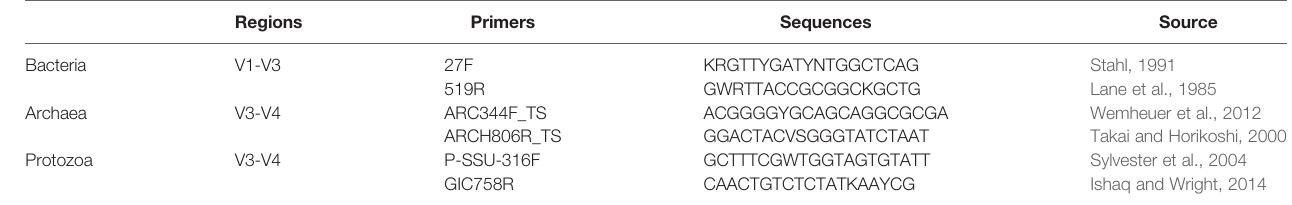
TABLE 2 | Primers for PCR ampli fi cation of bacterial, archaeal, and protozoal communities. Regions